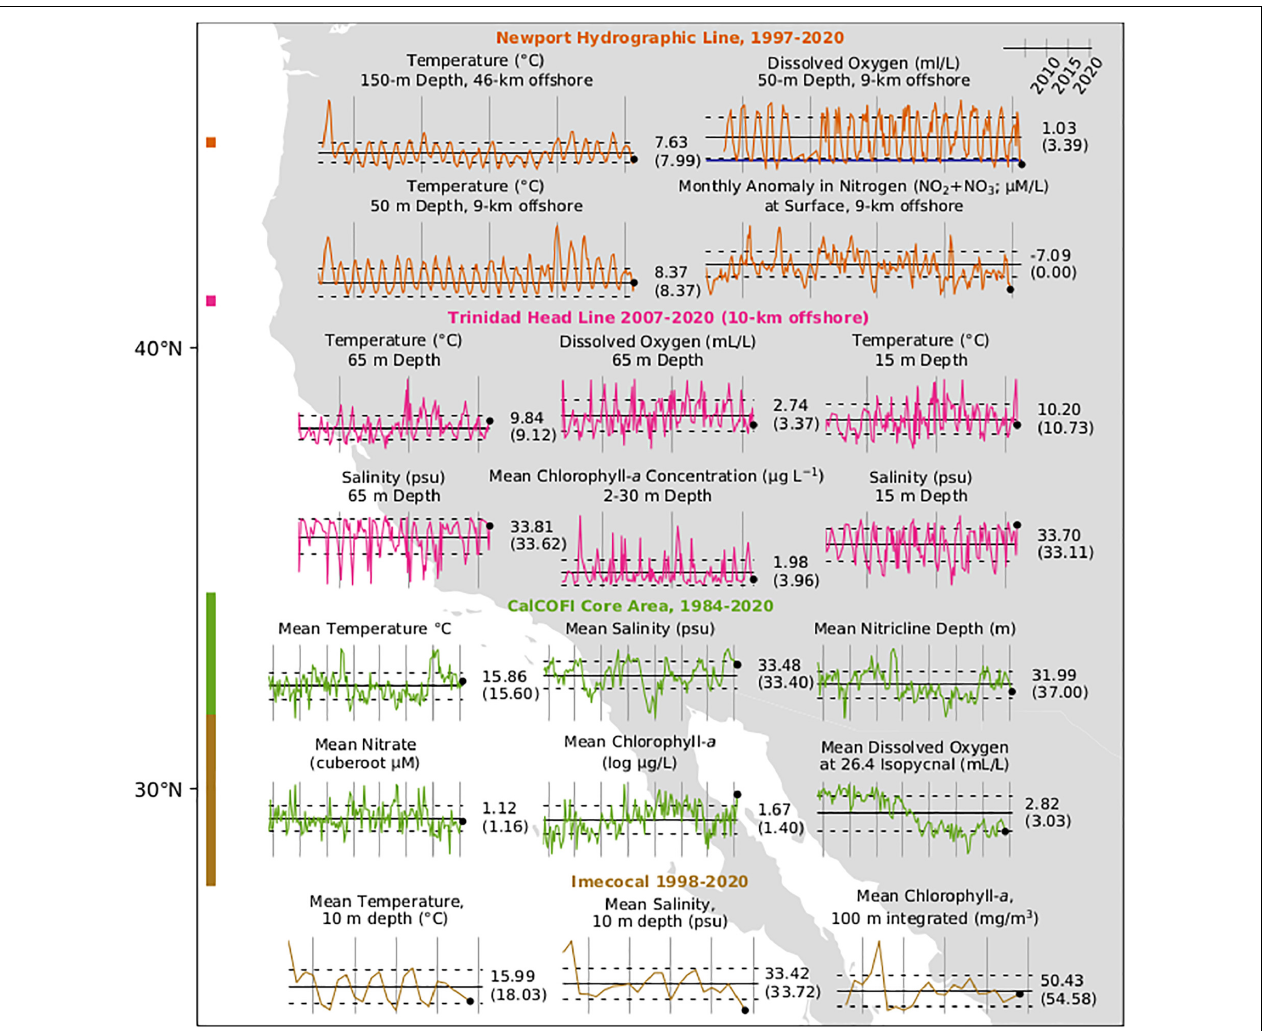
FIGURE 5 | Regional environmental and chlorophyll- a measurements in the California Current. Bars at left indicate the latitudinal sampling range of the surveys with colors corresponding to graphed data. Numbers to the right of each series indicate the value of the final measurement (black dot) and long-term mean (horizontal bar) in parentheses. Vertical bars are at 5-year intervals with the right-most bar at January 1, 2020. Dotted lines indicate ± 1 SE. The dark blue line on the oxygen graph for NHL indicates 1.4 ml/L, below which hypoxic conditions exist. Monthly anomalies in Nitrogen at NHL are with respect to 1996–2014 climatology. Values for CalCOFI data are averages within the mixed layer except for nitricline